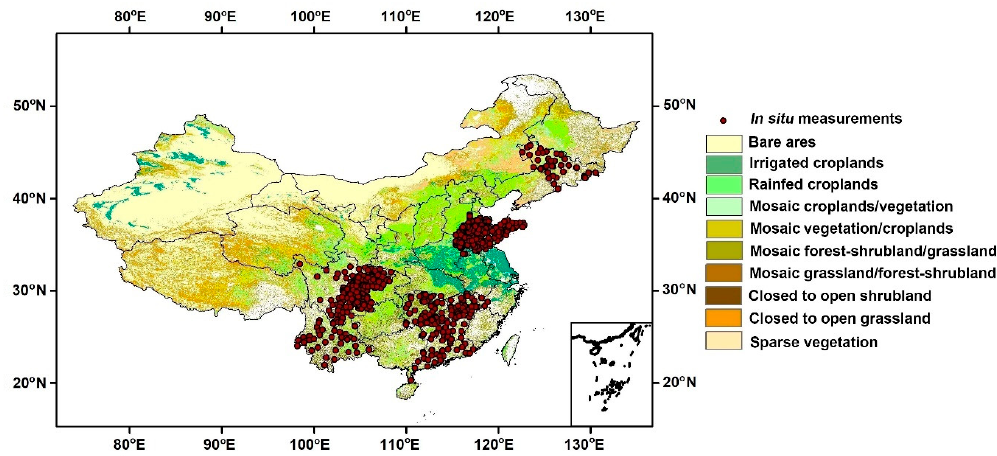
Figure 1. Locations of the 588 in situ soil moisture (SM) sites in Mainland China. The background map is the Global Land Cover Map for 2009 (GLCover 2009) data set. Table 3. Characteristics of the in situ measurements.